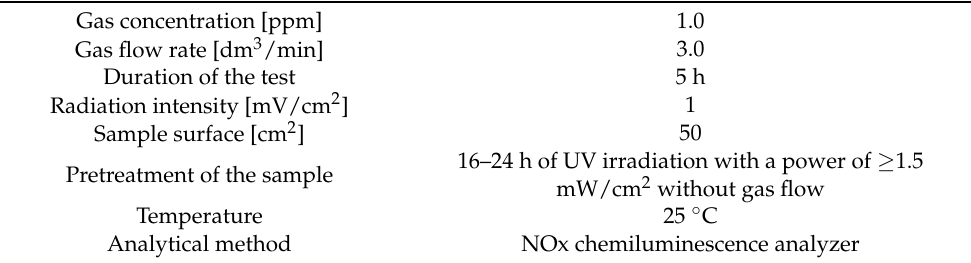
Table 2. Parameters of the photocatalytic efficiency test according to ISO